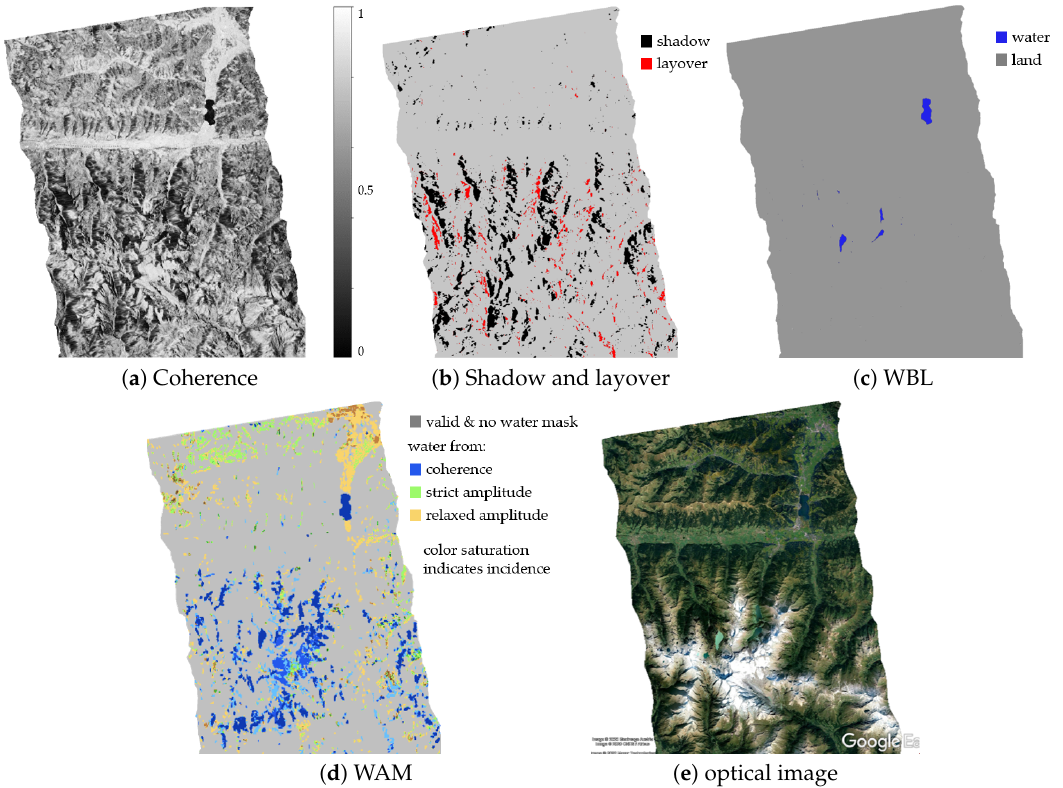
Figure 3. Generation of the TanDEM-X water-body layer (WBL). ( a ) Coherence, ( b ) shadow and layover, ( c ) classified WBL, ( d ) water mask layer (WAM) layer ( e ) optical image from Google